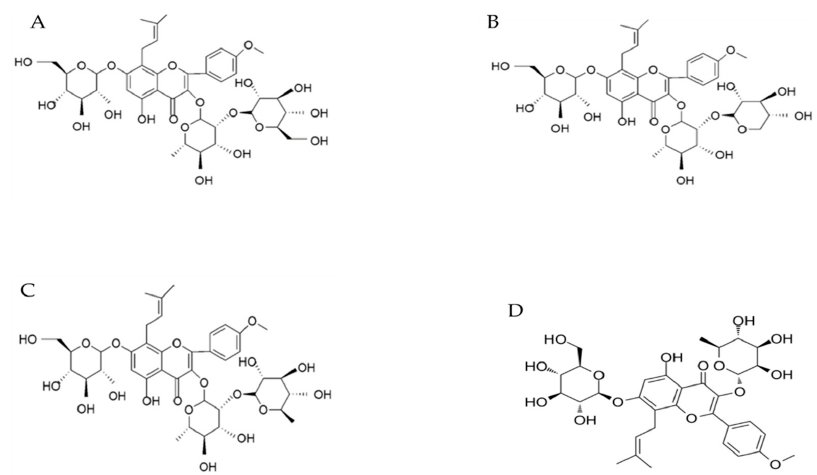
Figure 2. Chemical structures of the main bioactive components extracted from Epimedium brevicornum . ( A ) epimedin A, ( B ) epimedin B, ( C ) epimedin C, and ( D ) icariin.